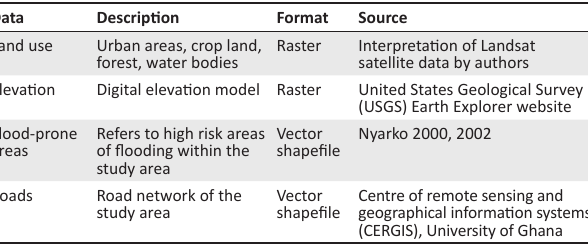
TABLE 1: The geospatial data used in this study.